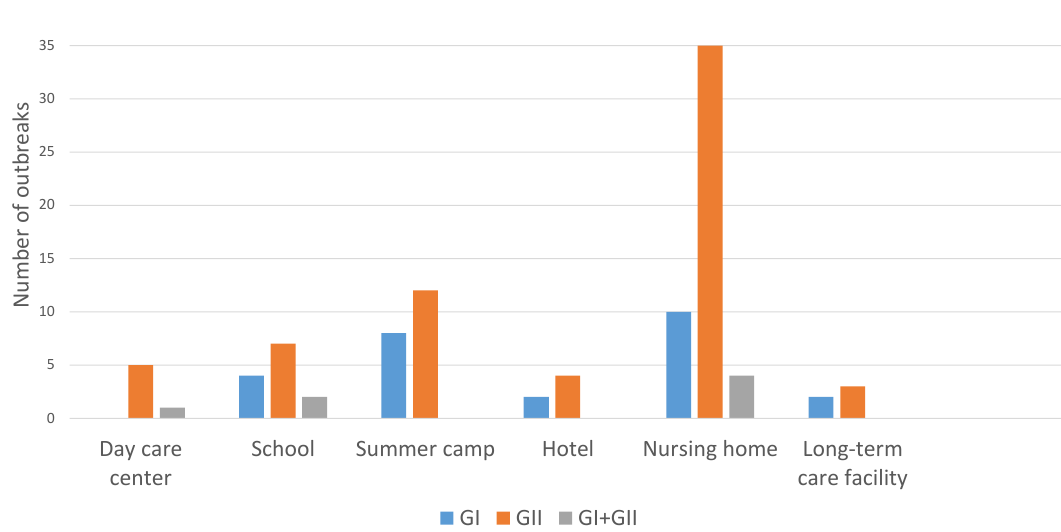
Figure 2. Outbreaks according to type of center and genogroup.